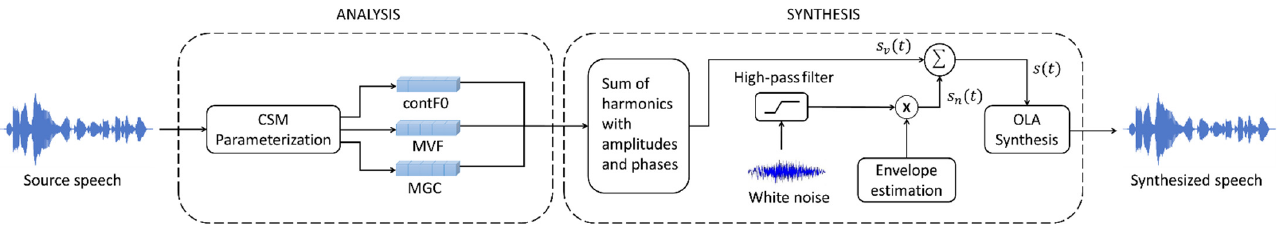
Figure 1. Overview of the developed system. CSM consists of three analysis algorithms (for determining the contF0, spectral envelope, and MVF) and a synthesis algorithm incorporating these parameters.